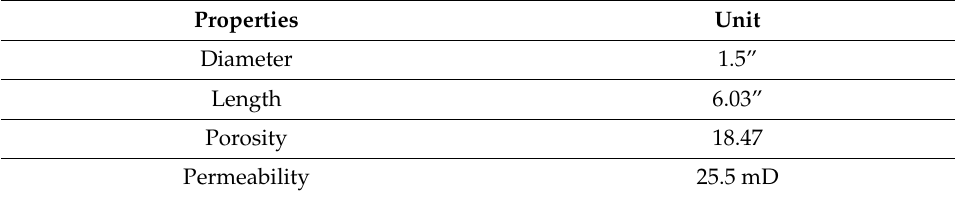
Table 2. Properties of carbonate core samples.